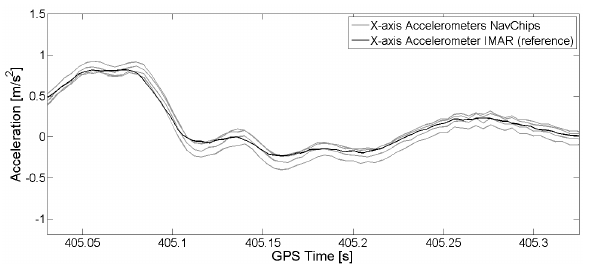
Figure 3. Time-alignment of NavChip acceleration to the reference